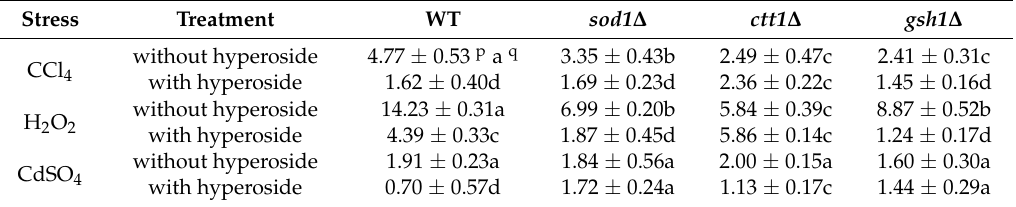
Table 1. Effect of 20 mg/L hyperoside on the level of ROS in yeast